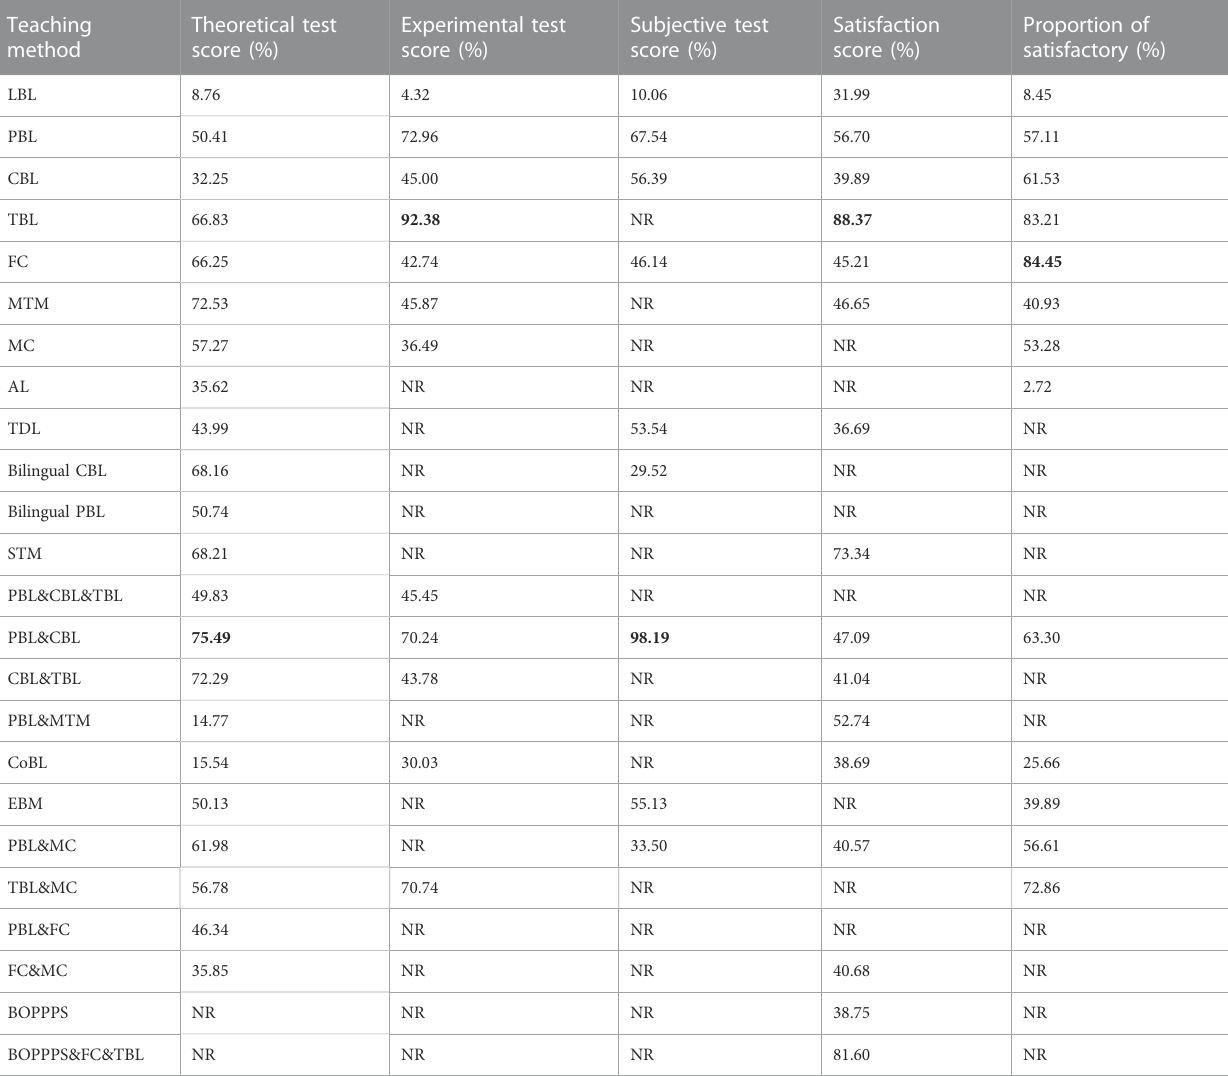
TABLE 1 Surface under the cumulative ranking probabilities analysis (SUCRA) results for fi ve outcome indexes. Teaching